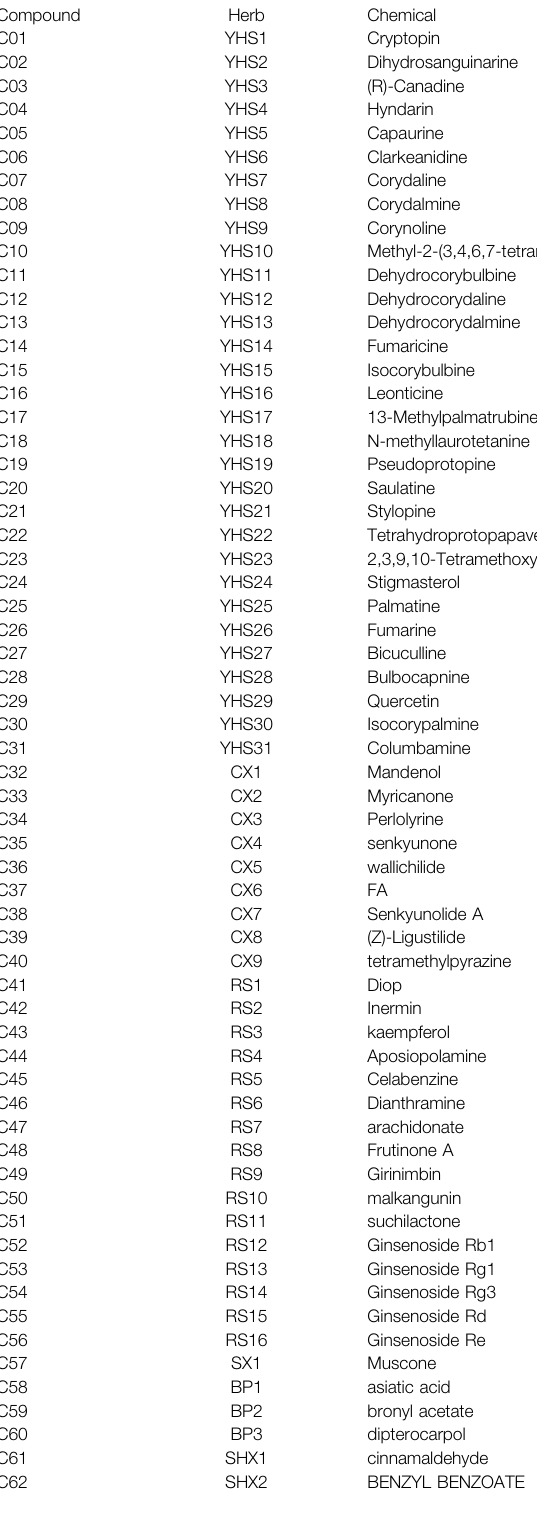
TABLE 1 | Active compounds of six herbs and their OB and DL.